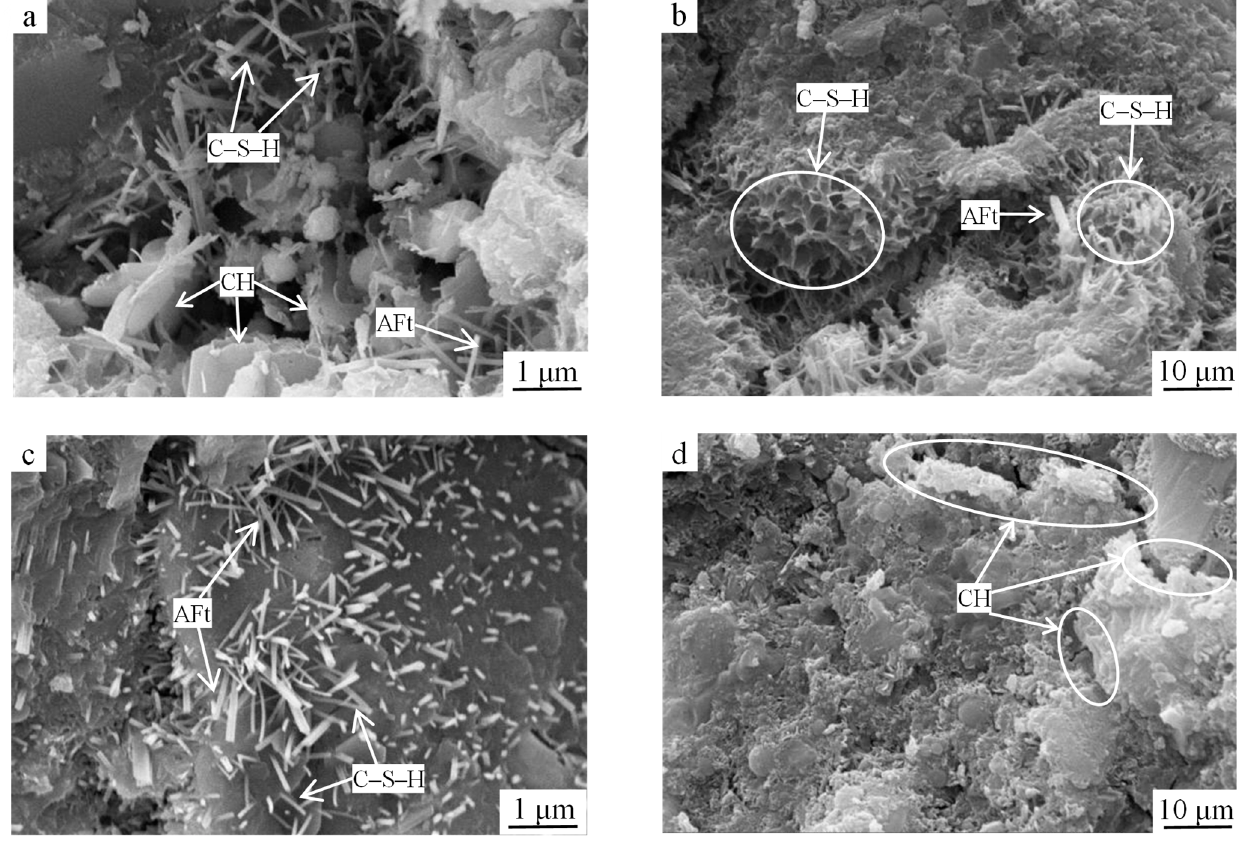
Figure 7. SEM images of the reference group samples at ( a , b ) 3 d of age and ( c , d ) 28 d of